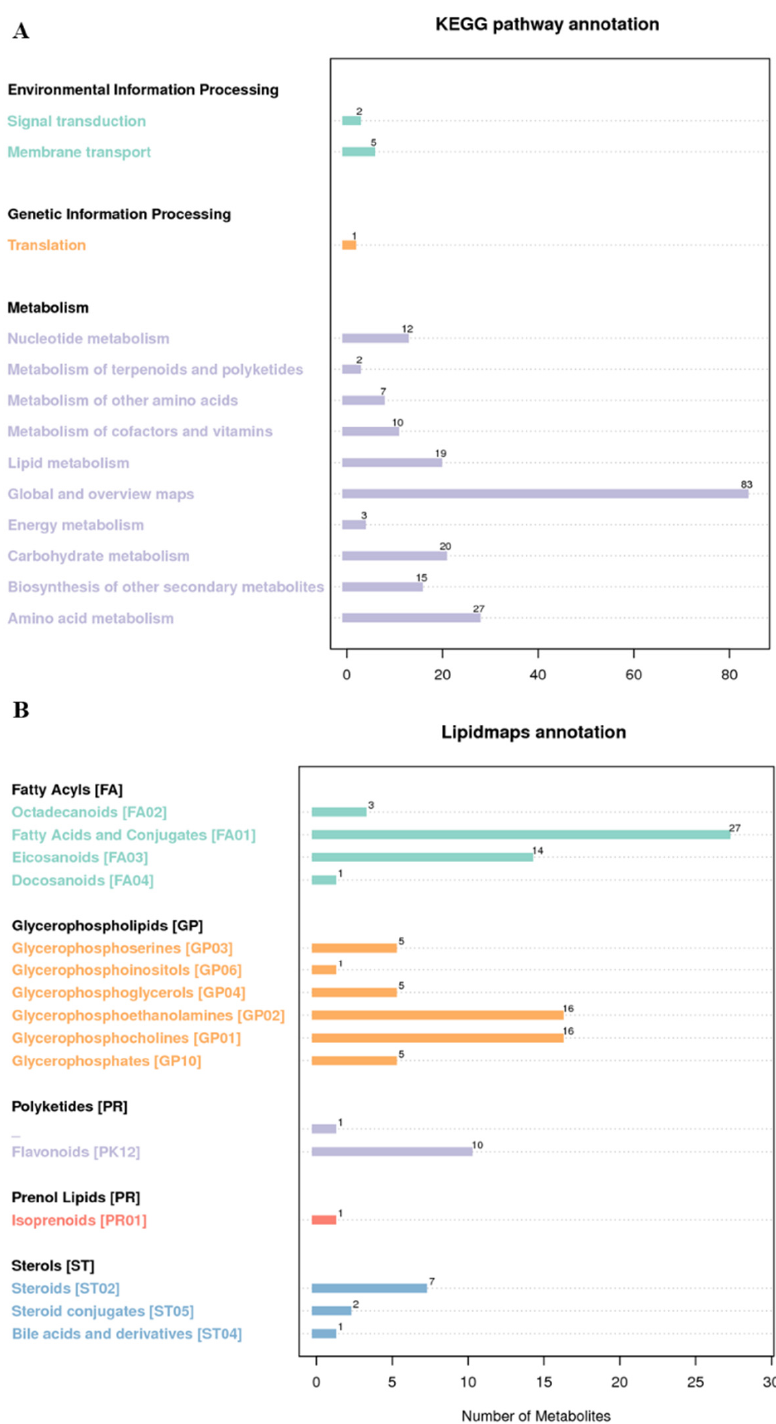
Figure 5. KEGG ( A ) and LIPID Maps ( B ) annotation results.